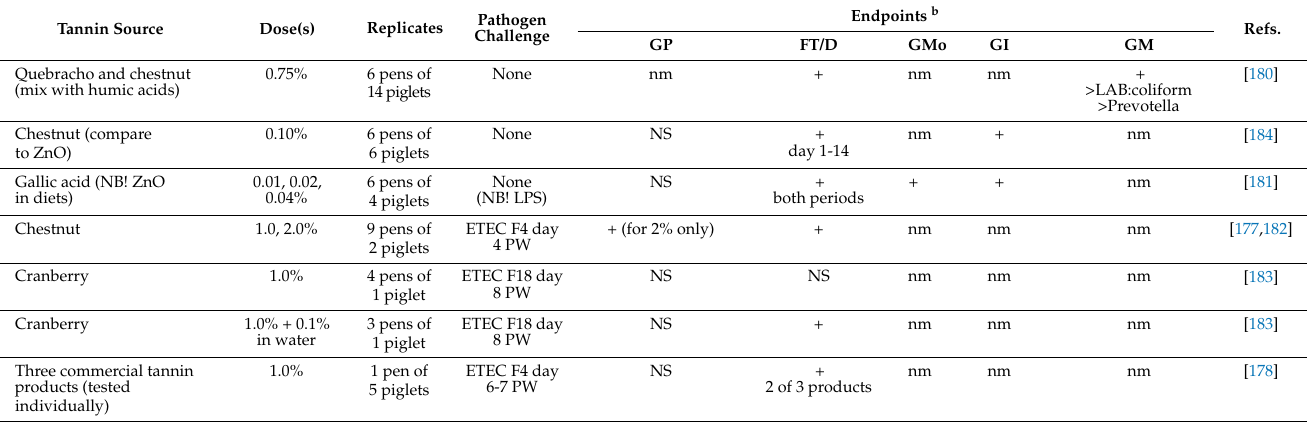
Table 6. Effects a of tannins on various parameters in